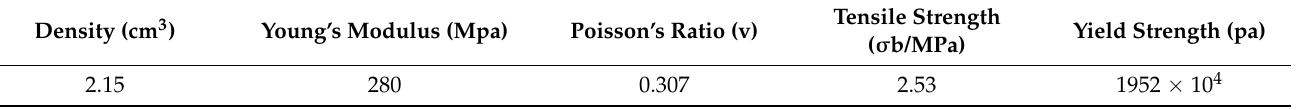
Table 2. Parameters of the carport membrane material